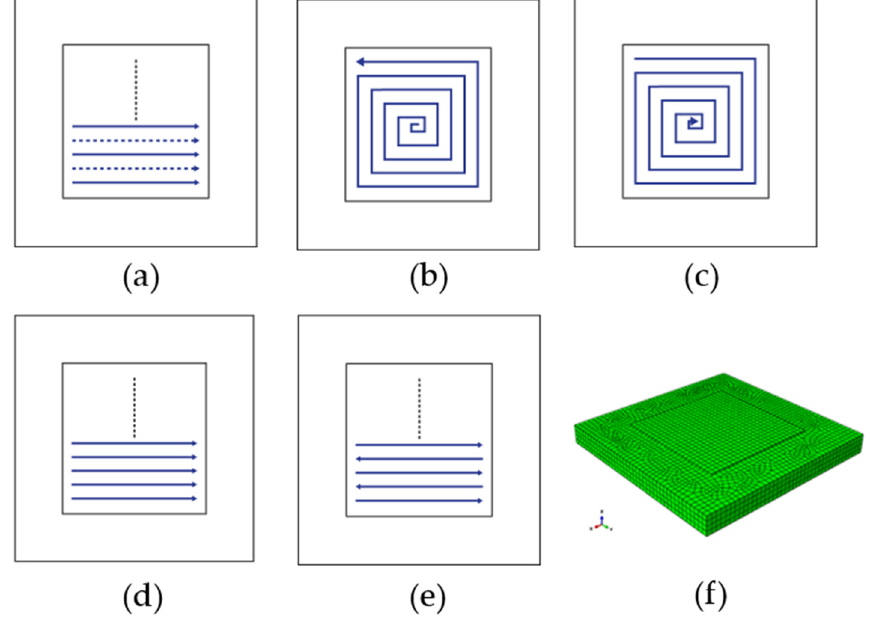
Figure 2. Deposition patterns analyzed (( a ) alternate, ( b ) in–out, ( c ) out–in, ( d ) raster, and ( e ) zigzag) and ( f ) the FE model used in the present work.